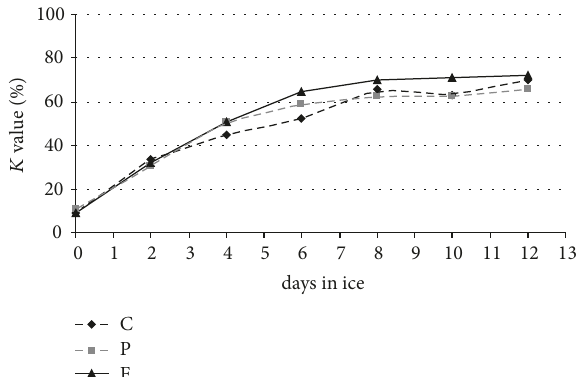
Figure6: 𝐾 -value(%)forthethreecommoncarpgroups(C:control diet; F: fish meal/fish oil diet; P: plant-based diet) stored in ice.